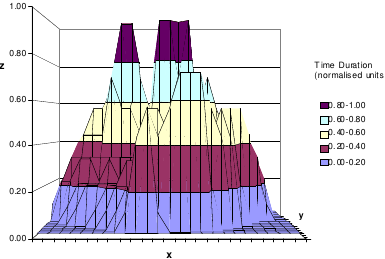
Figure 6(b). Isometric projection of time duration data with twin dominant peaks representing gathering sites for cows and areas of high excretion frequency and nitrogen emissions.